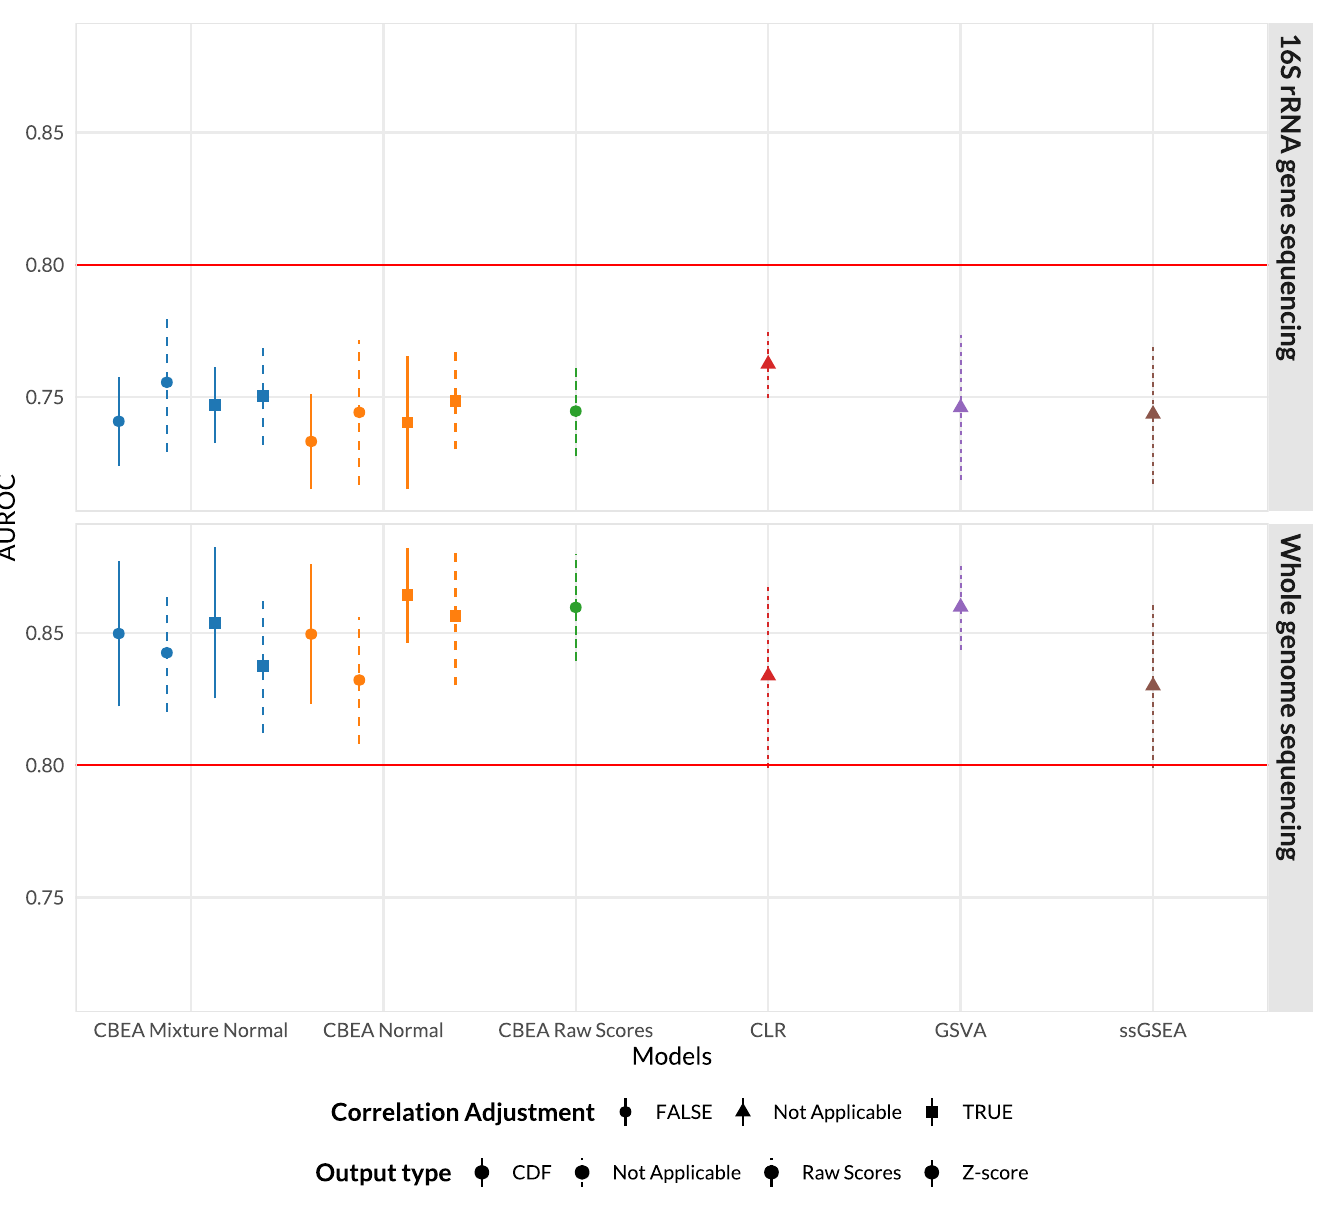
Fig 6. Predictive performance of a naive random forest model trained on CBEA, ssGSEA, and GSVA generated scores, as well as the standard CLR approach on predicting patients with inflammatory bowel disease versus controls using genus level taxonomic profiles. The data sets used span both 16S rRNA gene sequencing (Gevers et al. [57]) and whole-genome shotgun sequencing (Nielsen et al. [56]). CBEA performs better than GSVA and ssGSEA but not as well as CLR, with the exception of the whole genome sequencing data